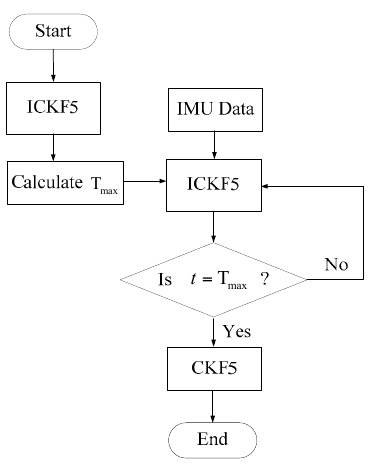
Figure 2. The flow chart of IICKF5.